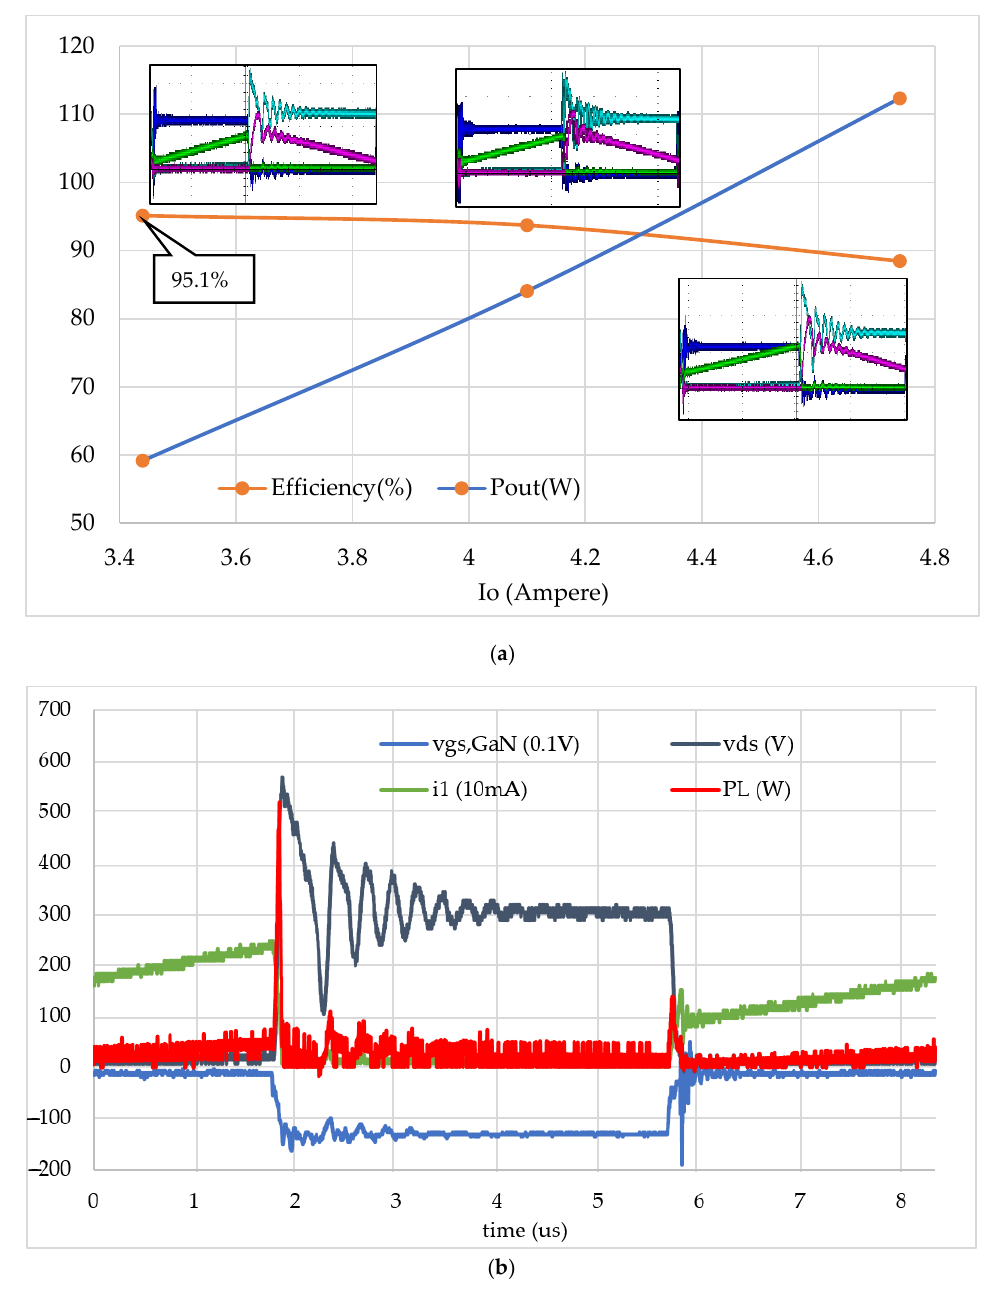
Figure 17. Type 2A CCM results of V DD = 150 V and R o = 5 Ω ( a ) comparison of different output current, and ( b ) switching frequency f s = 100 kHz, V o = 17 V and duty 43%. Table 6. Comparison of DCM and CCM at 60 W output when turn ratio a = 6.24.